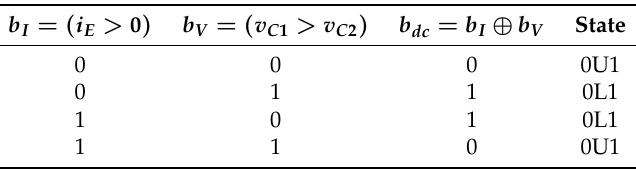
Table 3. Logic for selecting the states 0U1 and